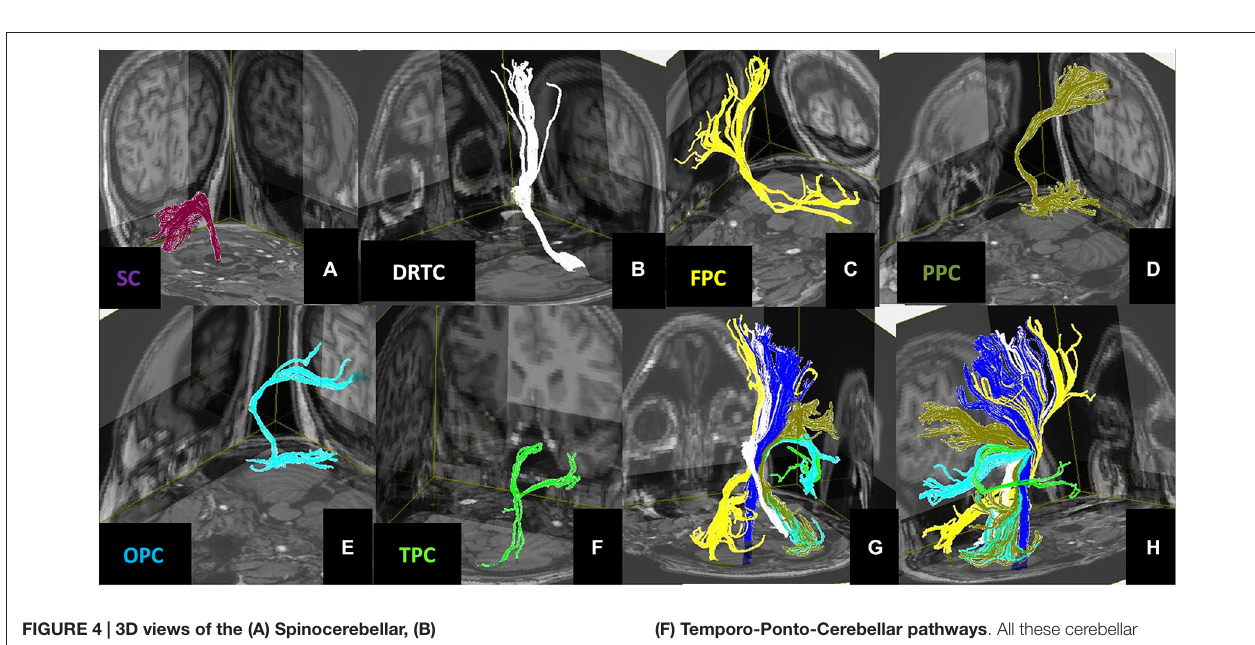
(G) axial section of parietal lobe for parieto-ponto-cerebellar (PPC), (H) coronal section of temporal lobe for temporo-ponto-cerebellar (TPC) and (I) coronal section of occipital lobe for occipito-ponto-cerebellar (OPC) pathways are chosen as second ROI. DTI color coded (a, b and e–j and b0 (c and d) maps are used for ROI determination.